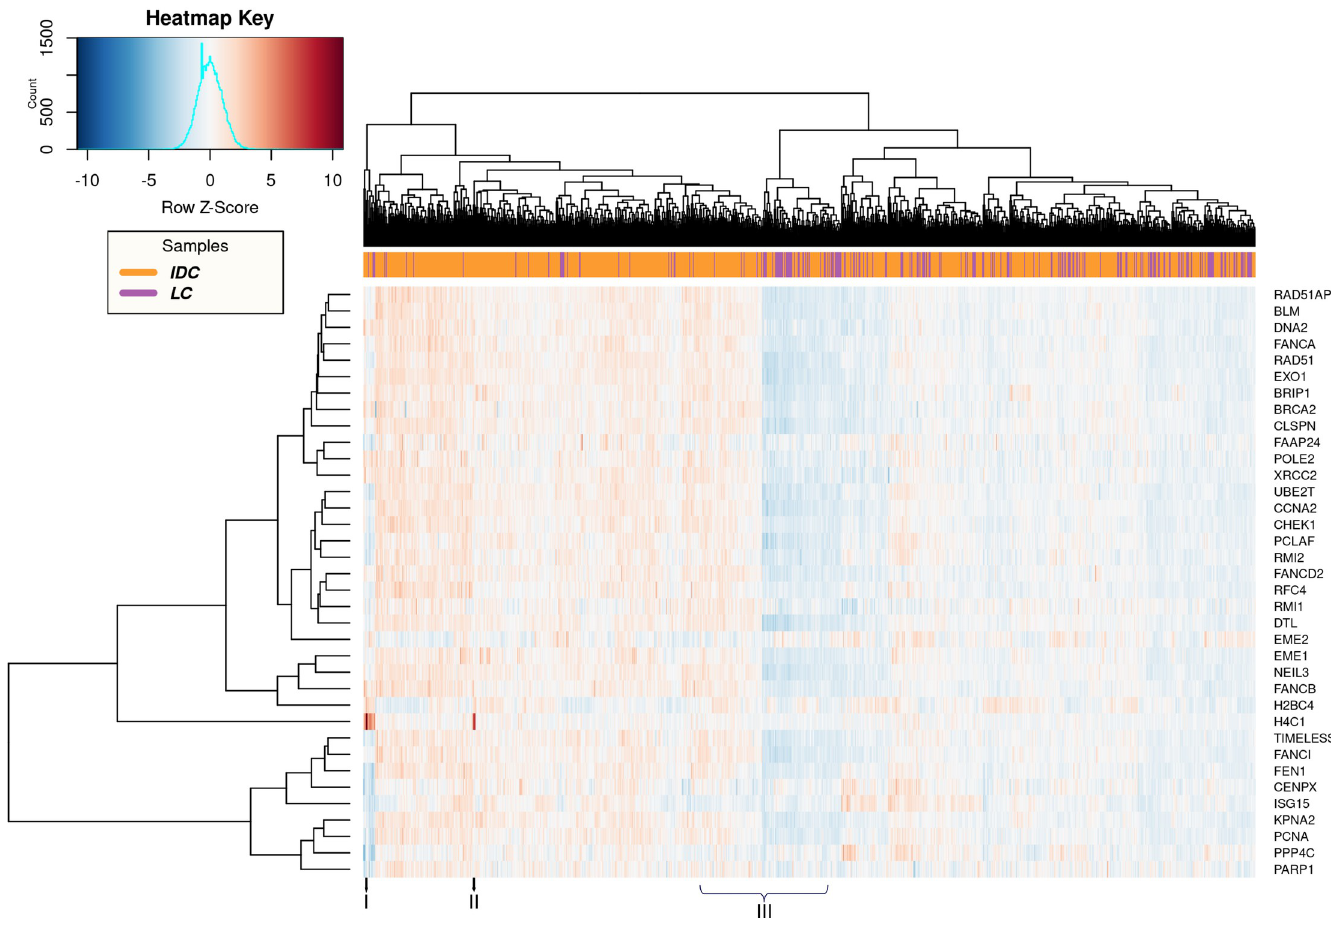
Fig 5. Heatmap representing the 36 DNA repair DEGs in IDC vs LC . IDC (Orange) and LC (Purple).